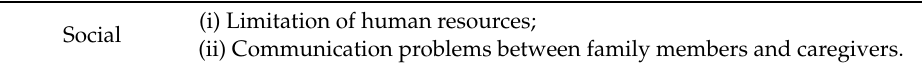
Table 6. Barriers to PA practice in the perception of project leaders.